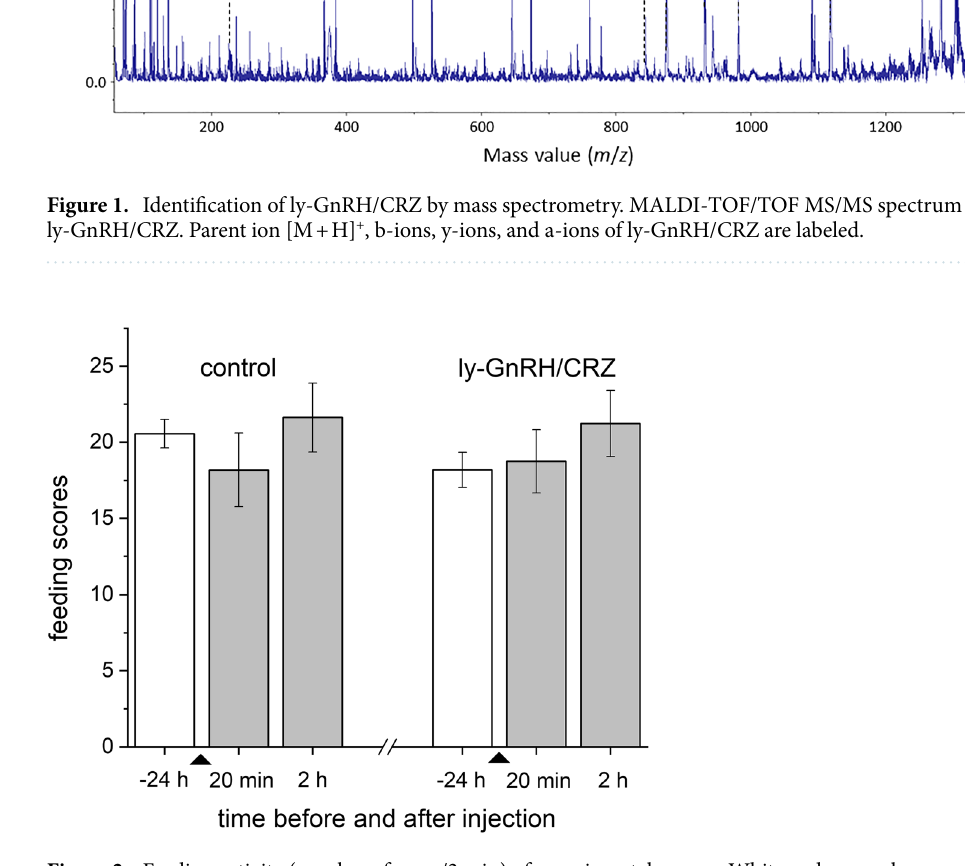
glion. In Fig. 4, one double-labeled neuron can be observed in the representative section of the anterior lobe. Some ly-GnRH/CRZ-immunoreactive (ir) neurons not labeled with nickel chloride were also observed suggest- ing that not all ly-GnRH/CRZ-containing neurons project to the penis nerve. The positions of the ly-GnRH/ CRZ-ir neurons were consistent with the positions previously reported for this ganglion 5 . Among peripheral tissues, we investigated the penial complex (Supplementary Fig. 7) and heart by confocal imaging to reveal if ly-GnRH/CRZ modulates the multi-messenger innervation of these tissues as predicted